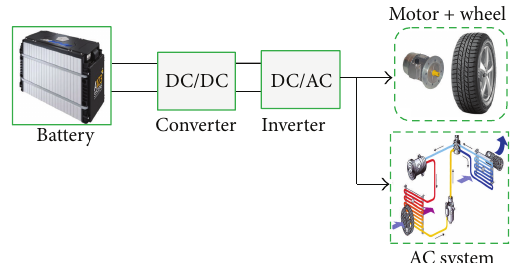
Figure 2: Simplified diagram of the vehicle power